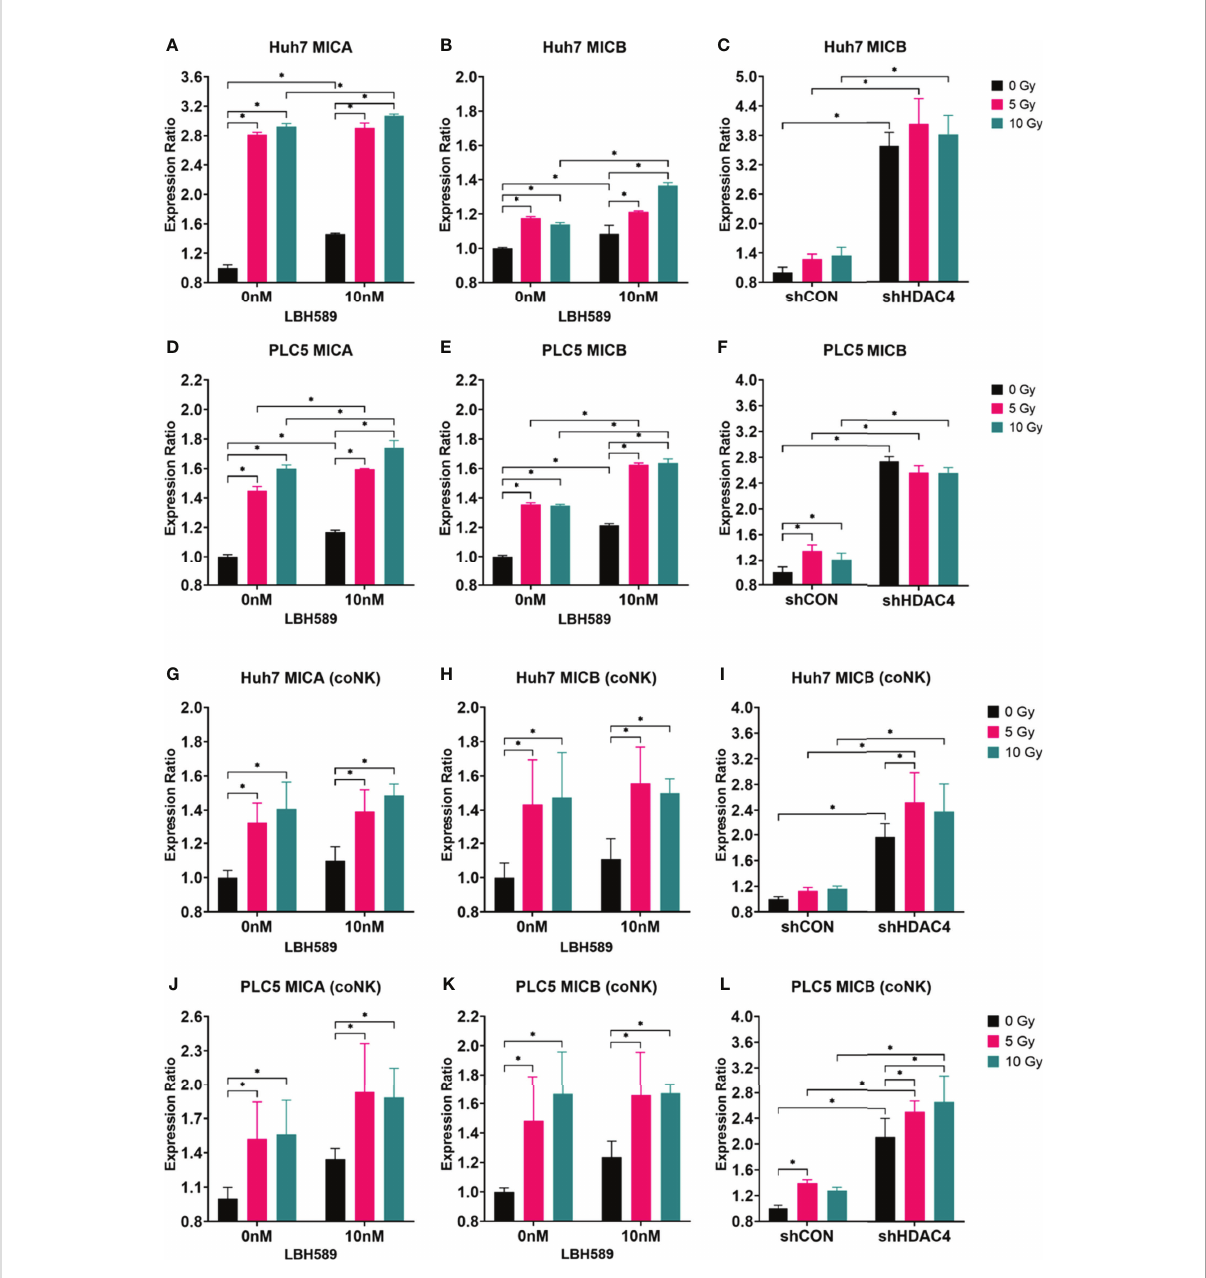
FIGURE 2 Effect of HDAC inhibition and radiotherapy (RT) on NKG2D ligand expressions in human HCC cells co-cultured with (coNK) or without NK cells. (A – F) Wild-type, vector-control shRNA (shCON) or HDAC4 shRNA knockdown (shHDAC4) PLC5 cells and Huh7 cells were treated with 10 nM of a pan-HDAC inhibitor, LBH589; (G – L) Wild-type, shCON or shHDAC4 PLC5 cells and Huh7 cells were co-cultured with or without 20000 NK cells. Combined LBH589 or shHDAC4 and RT signi fi cantly increased the expressions of NKG2D ligands (MICA/B) of HCC cells with or without the co-cultured NK cells. Error bars indicate SD, *P <